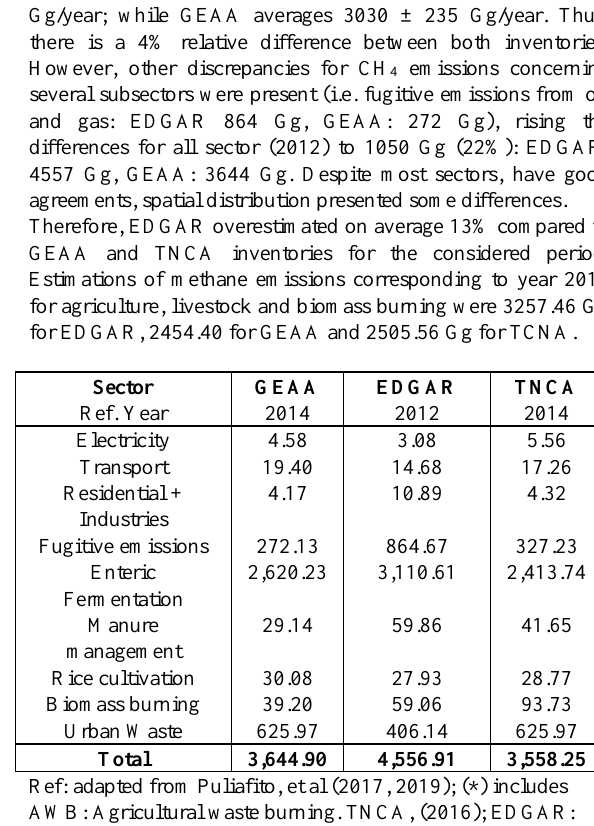
Table 1: Total methane emissions (Gg/year) from all sectors for Argentina 2016.